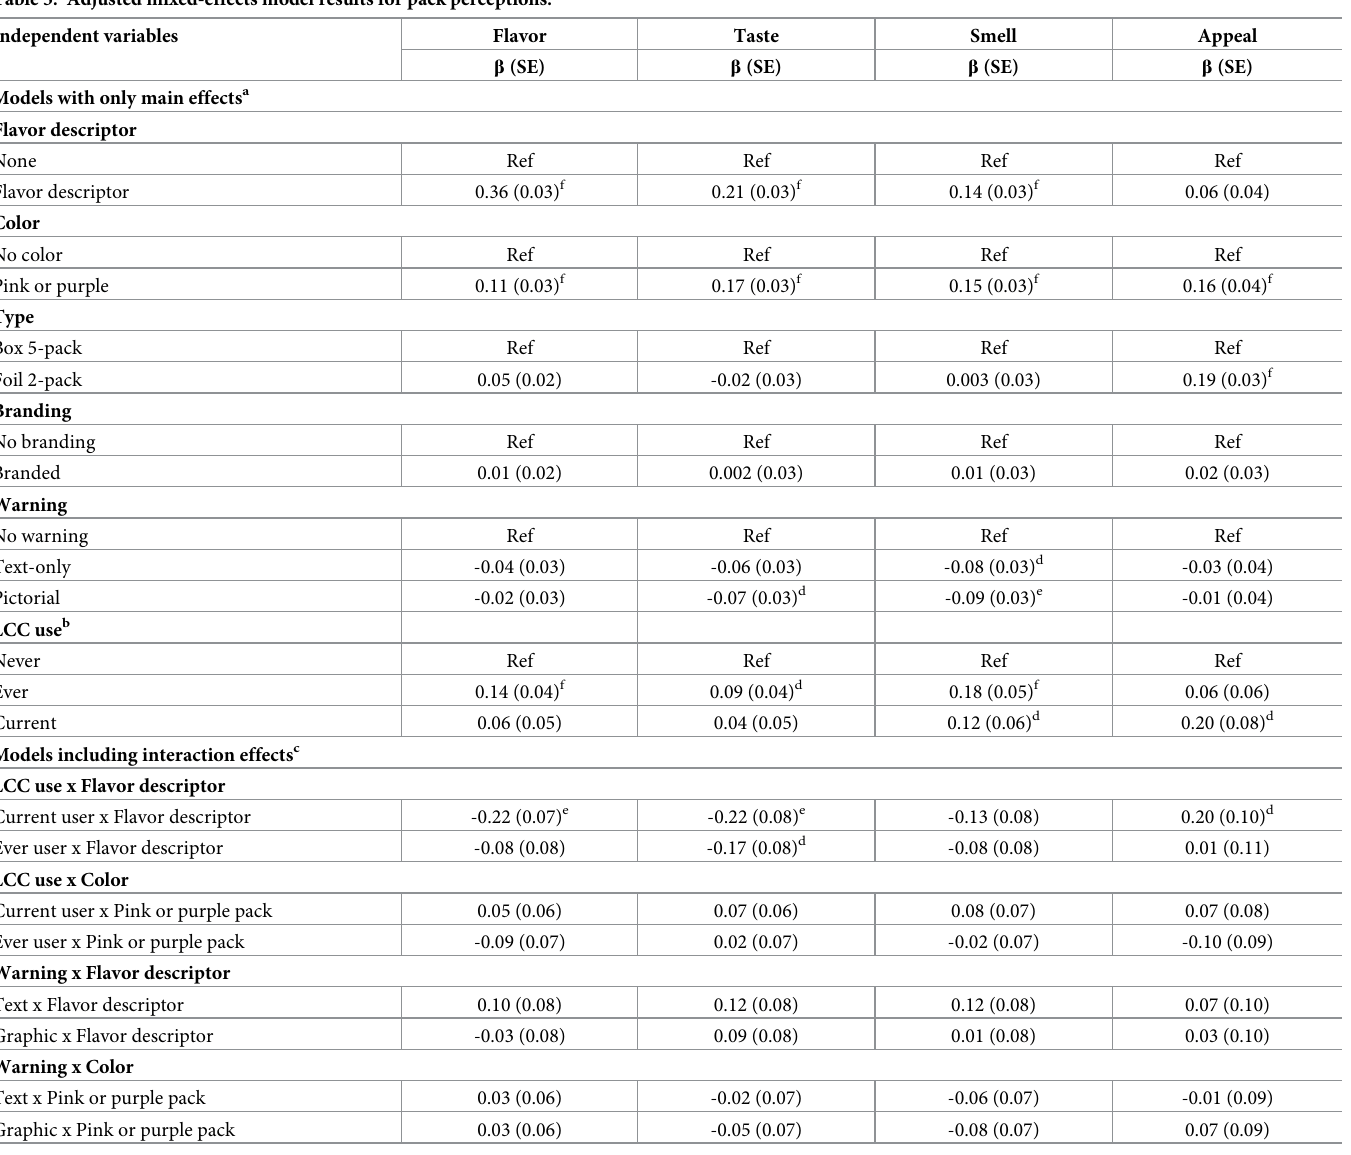
Table 3. Adjusted mixed-effects model results for pack